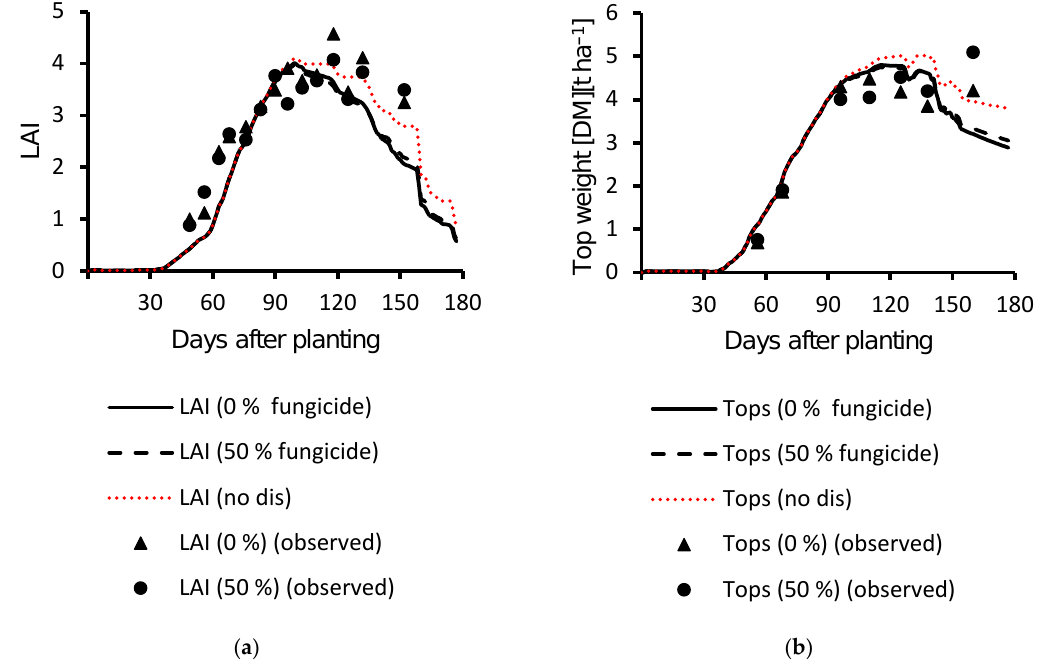
Figure 7. Simulated and observed values (2016) with Cercospora leaf spot ratings included in the simulation results: ( a ) LAI; ( b ) top weight (DM t ha −1 ) for the evaluation treatments with sugar beet growth simulated with current genetics and without Cercospora leaf spot disease ratings being included in the simulation process as “no dis” treatment.